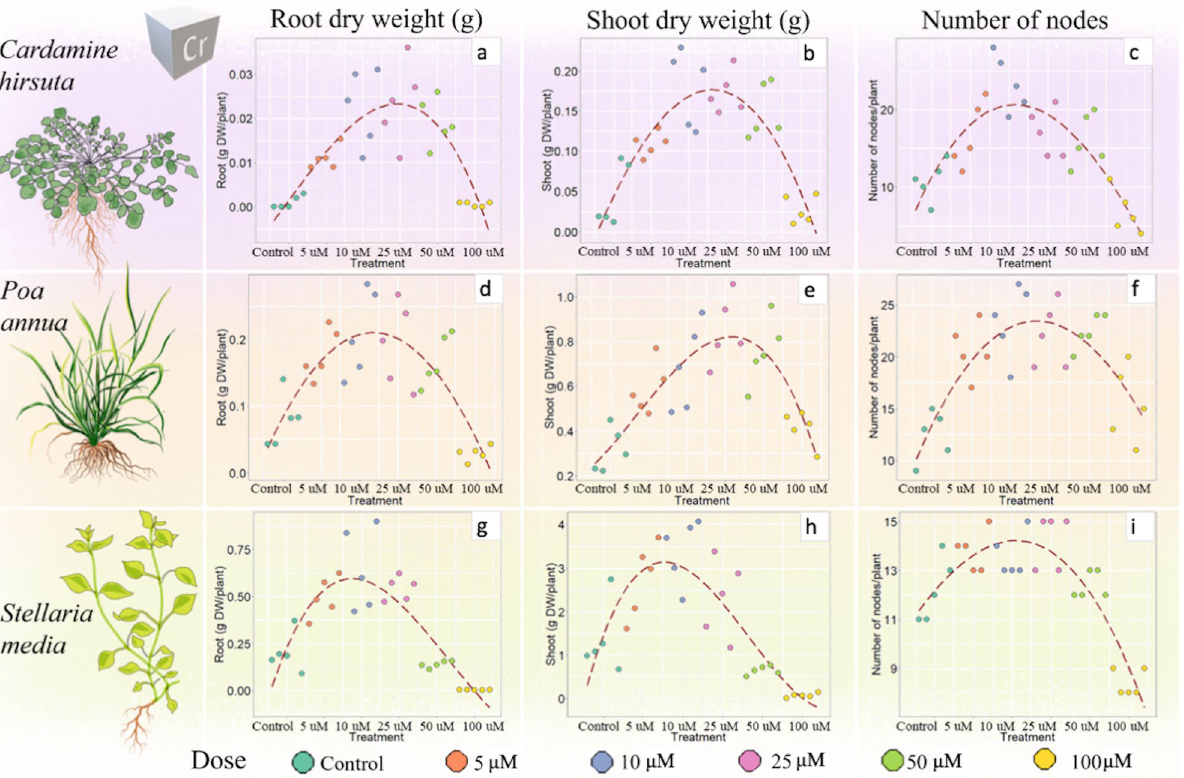
Figure 4. Effect of chromium on root and shoot dry biomass (g DW/plant) and number of nodes per plant in Cardamine hirsuta ( a – c ), Poa annua ( d – f ) and Stellaria media ( g – i ). A polynomial regression (dashed line) was applied to visualize the presence/absence of a hormetic curve. Each treatment is represented by 5 biological replicates (n = 5) (Supplementary Table 2). Drawings of plants by G.